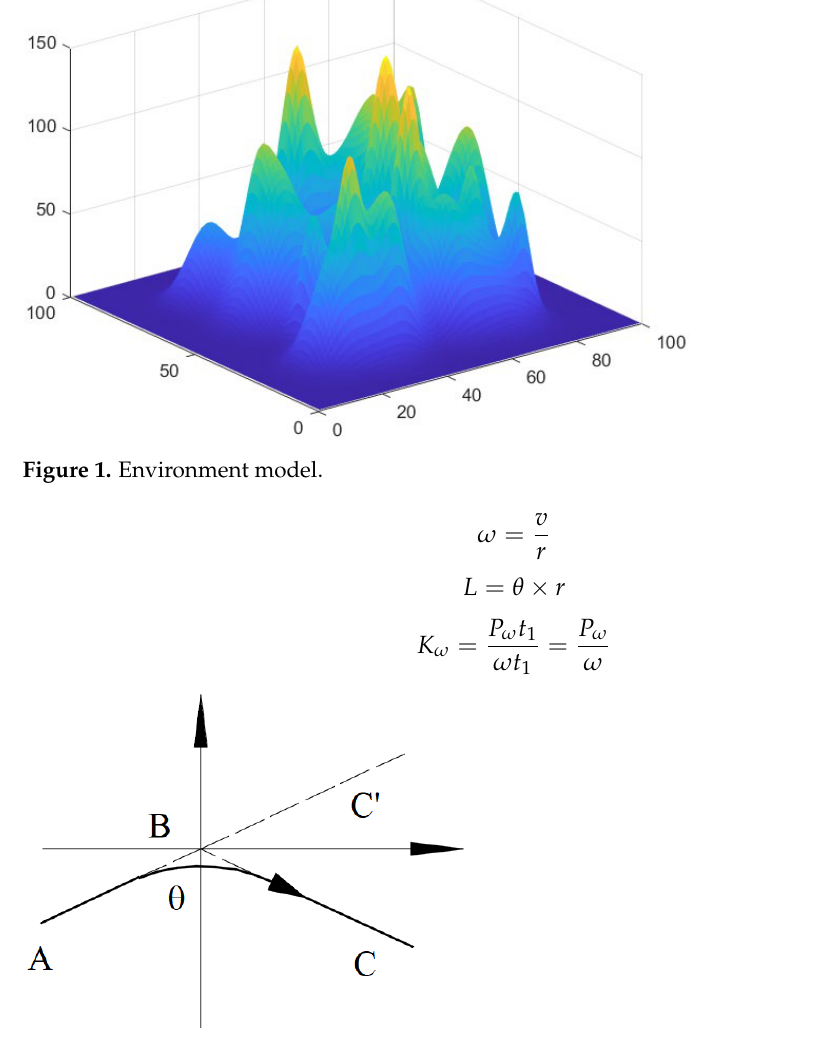
Figure 2. Corner route.